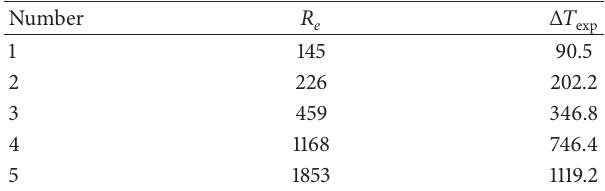
Table 4: The relationship of time difference and 𝑅 𝑒